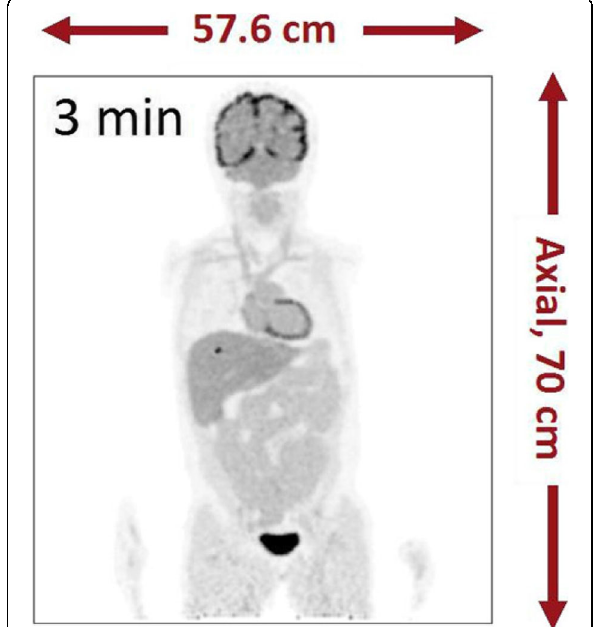
Fig. 4 (abstract A20). Image of the pediatric XCAT phantom simulated over a single bed position on the 70-cm PennPET Explorer scanner with a lesion in the liver. A scan covering this axial extent on the 23-cm scanner would require multiple bed positions. This phantom, along with an adult female phantom, will be used for future lesion detectability studies